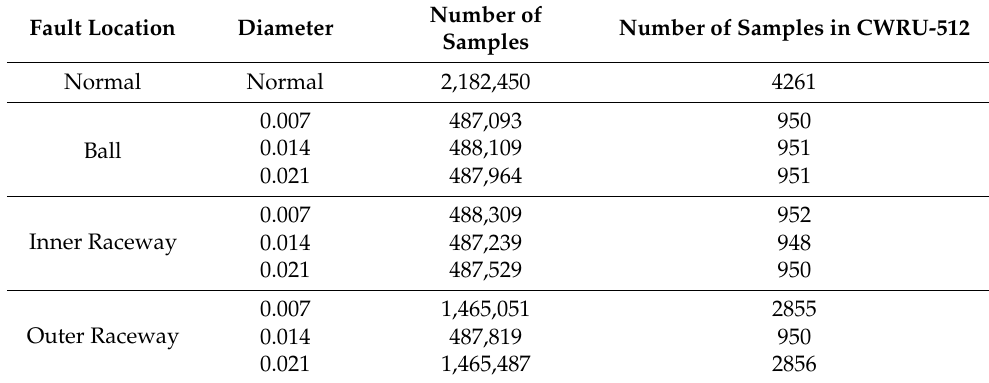
Table 2. Details of the CRWU-512 in the fault detection experiment.